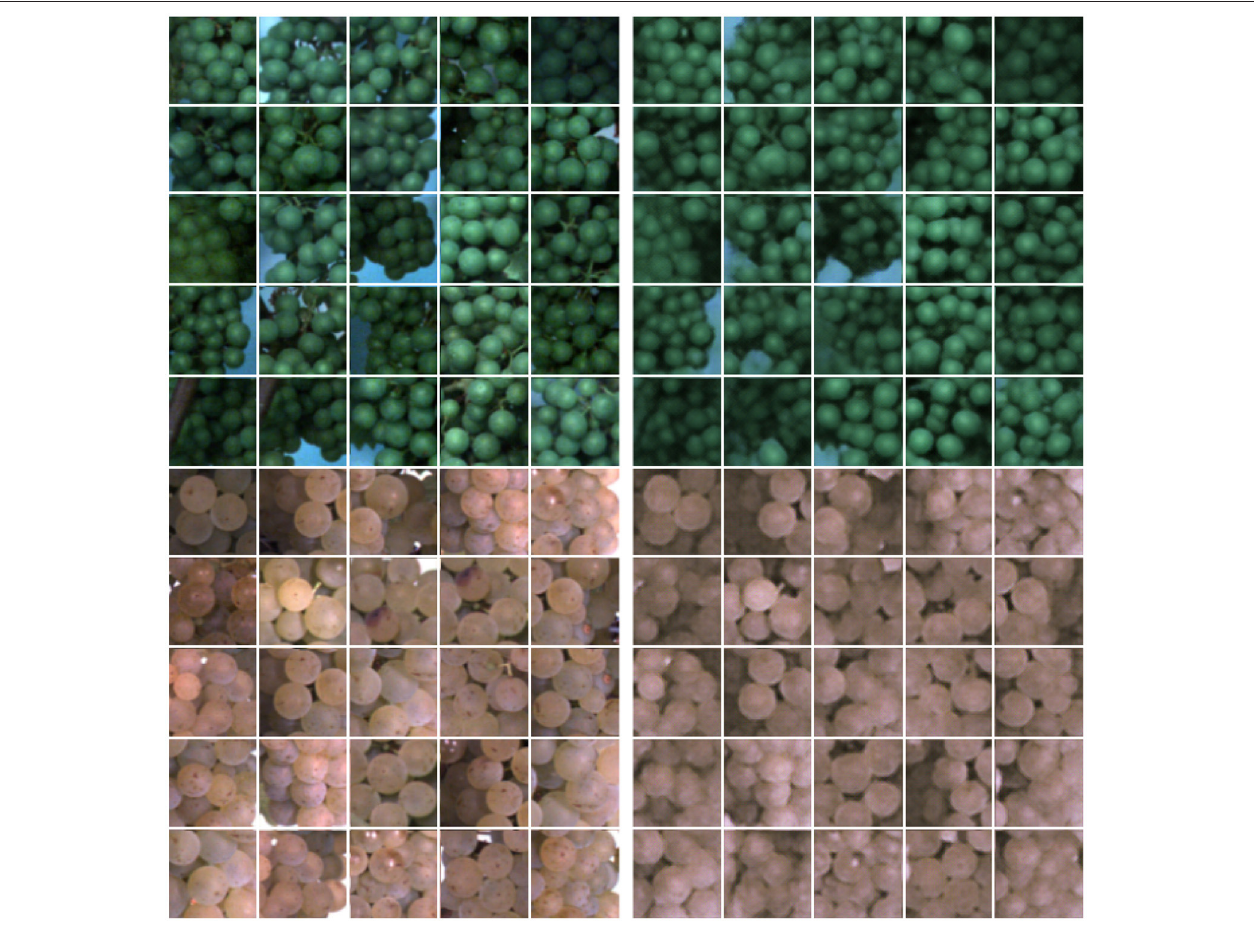
FIGURE 5 | Images and image reconstructions of non-anomalous grapevine image patches using our proposed FPL-VAE. The original image patches are displayed on the left side, and the corresponding reconstructions are displayed on the right. The upper patches show berries in the BBCH75 stage, and the lower ones shortly before harvest in the BBCH89 stage.